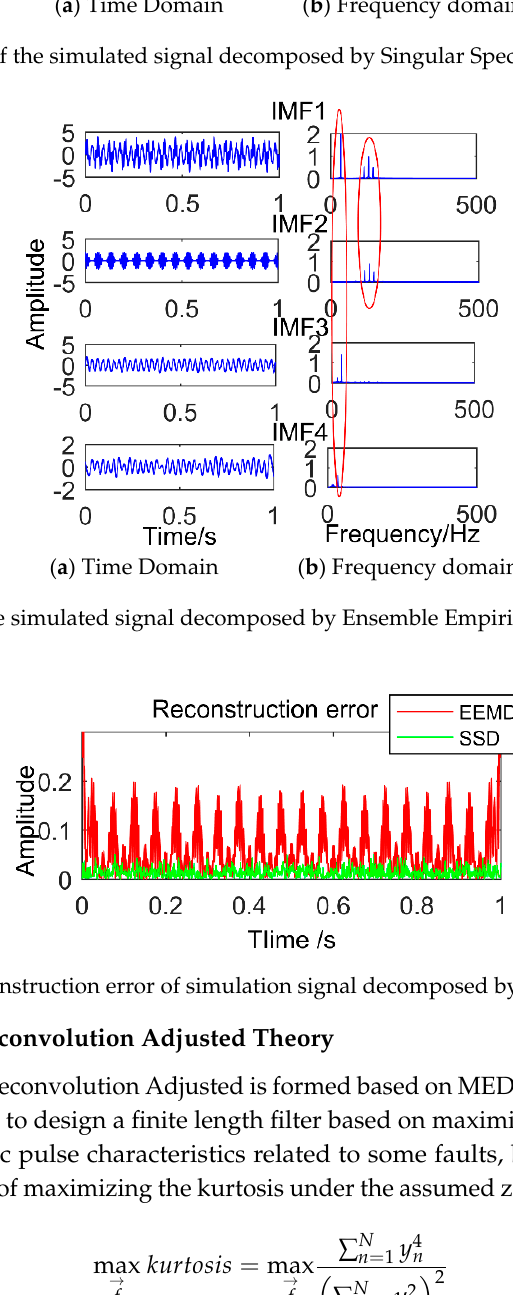
Figure 2. Results of the simulated signal decomposed by Singular Spectrum Decomposition.